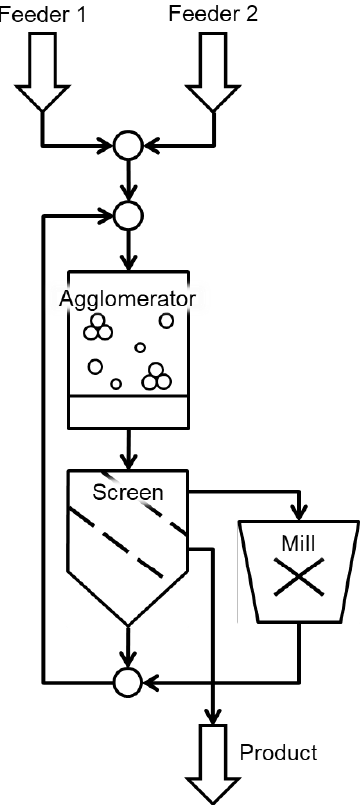
Figure 12. Flowsheet structure of a coupled agglomeration and breakage process.